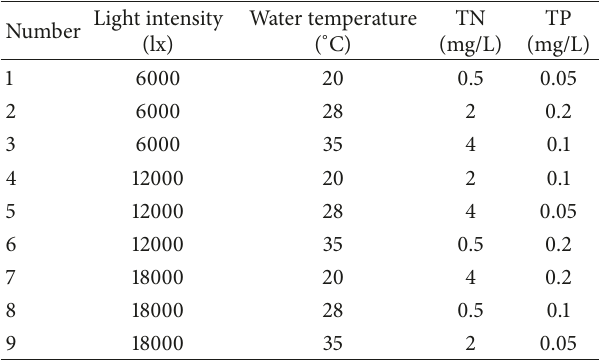
Table 2: Orthogonal experiment condition table for each